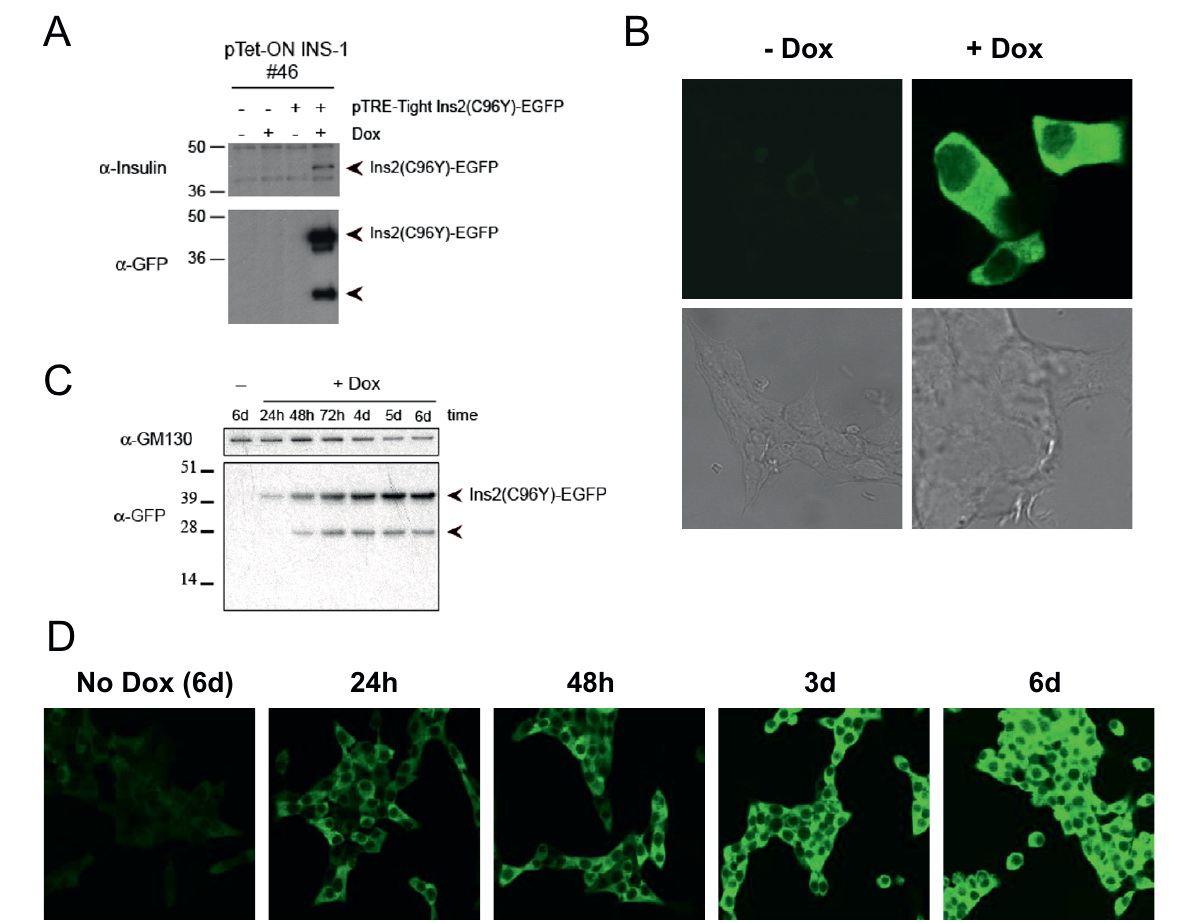
Figure 1 Induction of insulin 2 (C96Y)-EGFP protein expression in pTet-ON INS-1 cells by doxycyline . A-B . pTet-ON INS-1 #46 cells were transiently transfected with pTRE-Tight Ins2 (C96Y)-EGFP construct in the presence or absence of 2 μ g/ml doxycycline (Dox) for 48 h. In (A), cells were washed in PBS, lysed and 10 μ g of protein were resolved by SDS-PAGE and immunoblotted using antibodies to insulin and GFP. In (B) the cells were washed in PBS, fixed and mounted. GFP fluorescence was visualized using a laser confocal fluorescence microscope. C-D . A stable Ins2 (C96Y)-EGFP expressing INS1 clone (Clone #4S2), generated as described in the methods, was untreated (-Dox) or treated with 2 μ g/ml doxycycline (+Dox) for the times indicated. The cells were washed in PBS, lysed and an equal amount of protein per condition were resolved by SDS-PAGE and immunoblotted using antibodies to GM130 and GFP (C). In (D), EGFP fluorescence in fixed cells was visualized by confocal fluorescence